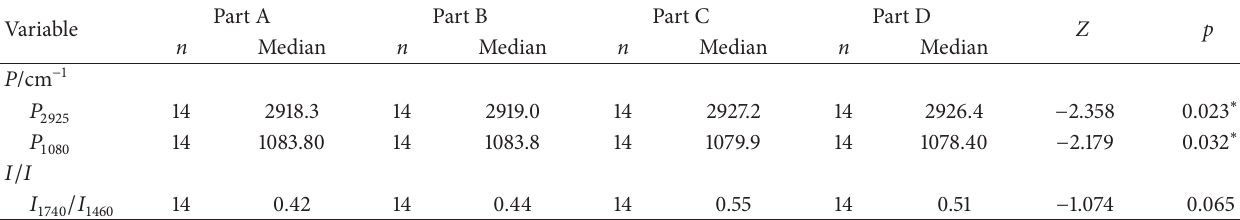
Table 3: FTIR spectrum comparisons of Parts A, B, C, and D ( rank-sum results).